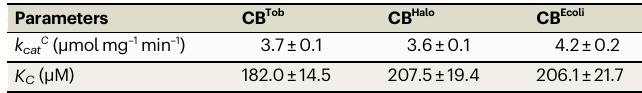
Table 1 | Catalytic parameters of puri fi ed carboxysomes from engineered chloroplasts H. neapolitanus , and E. coli